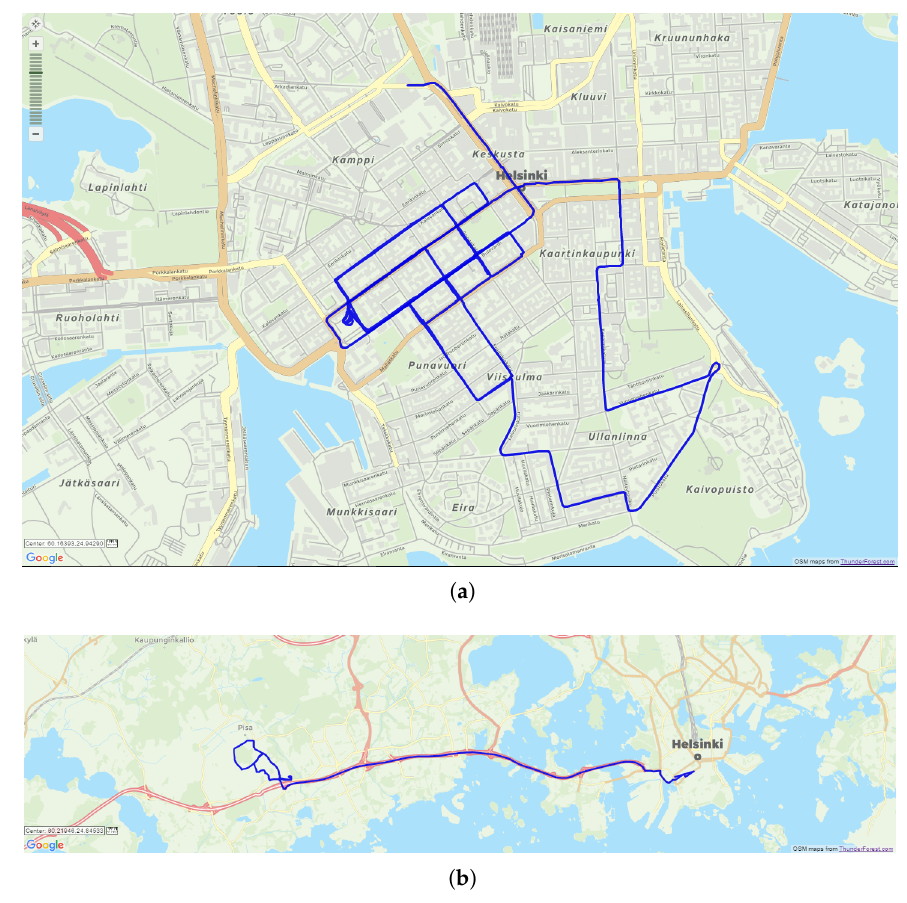
Figure 9. Datasets shown in Google Maps. ( a ) Urban and ( b ) suburban environments. The statistical characterization of the HPE related to the live and replayed trajectories is plotted in Figure 10a,b, respectively, by the continuous and dashed lines. Moreover, the blue and orange lines are related respectively to the suburban and urban environments. The CDFs of the HPE are plotted in Figure 10a.